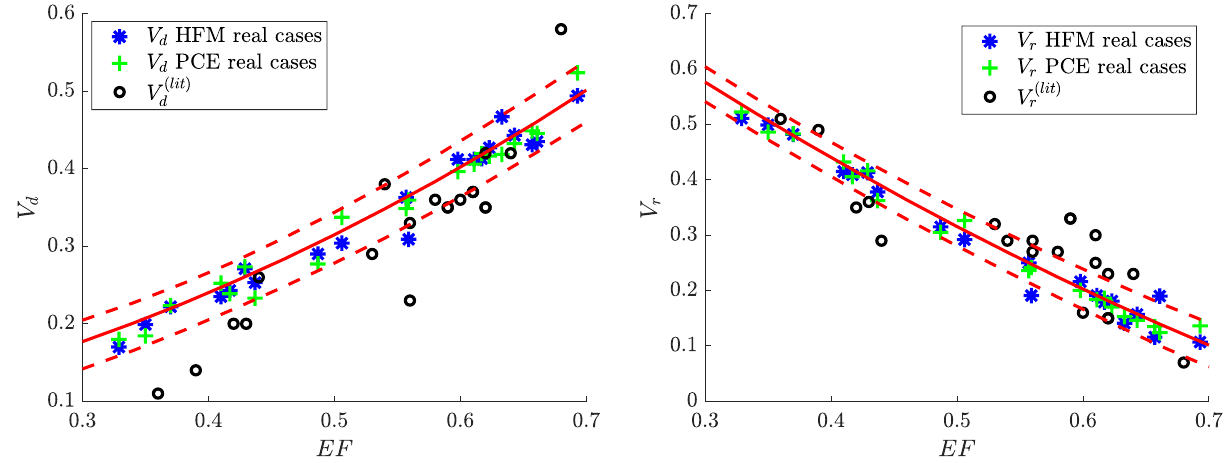
Figure 4. V d and V r against EF for the 20 patient-specific (real) cases analysed in this study and based on the predictions provided by the HFM and the PCE-based surrogate models. Other cases derived from literature, V ( lit ) r , are also represented. The red continuous line represents the mean of the QoI (either V d or V r ) V ( lit ) d and against EF obtained with the surrogate model, given the variability of the remaining parameters (red dashed lines represent the 1% and 99% quantiles).